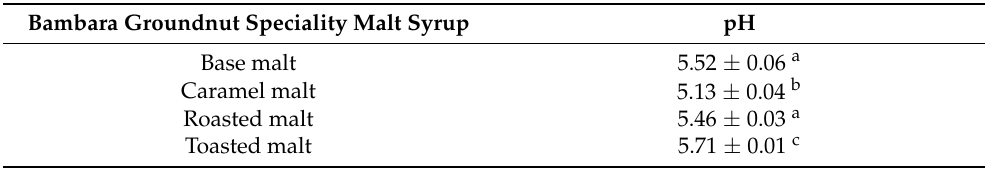
Table 3. pH characteristics of Bambara groundnut speciality malt syrups 1